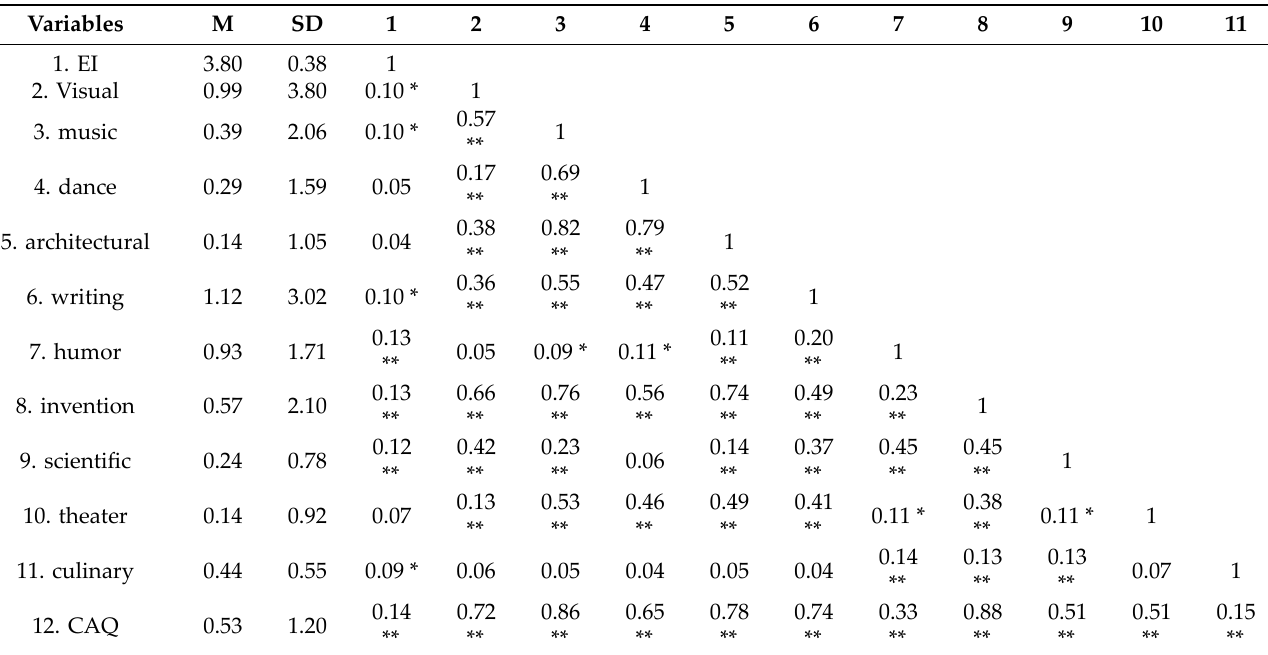
Table 3. Descriptive statistics and correlations between EI and creativity